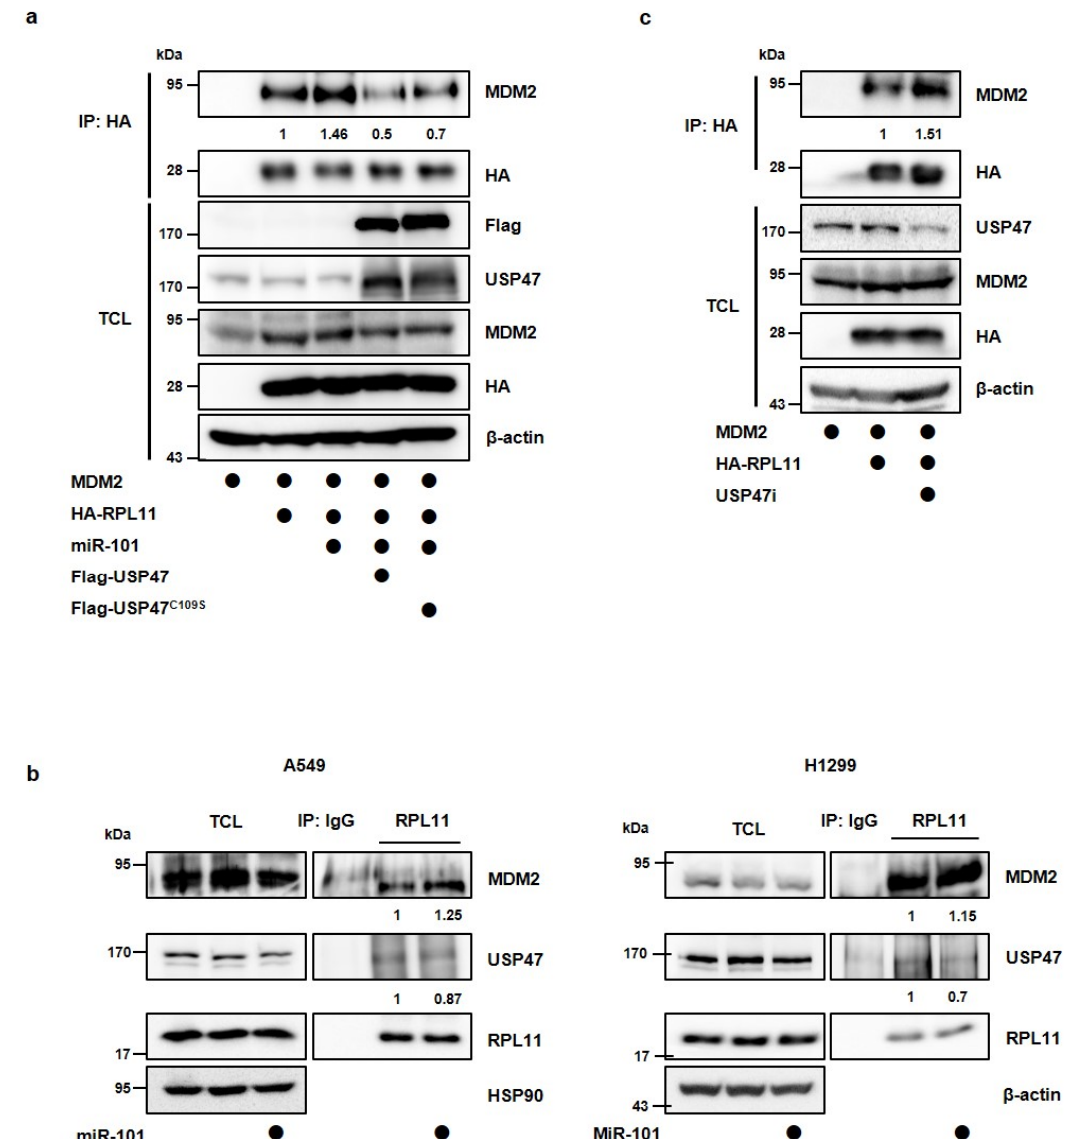
Figure 5. MiR-101-3p increases the interaction between RPL11 and MDM2. ( a ) HEK293T cells were co-transfected with MDM2, HA-RPL11, Flag-USP47, Flag-USP47 C109S , and miR-101-3p mimic. The interaction between MDM2 and HA-RPL11 was detected by immunoblotting after immunoprecipitation with anti-HA agarose beads. The quantification of MDM2 levels in the IP samples was carried out considering the amount of HA in each case of IP samples. ( b ) A549 and H1299 cells were transfected with a miR-101-3p mimic. The interaction between endogenous RPL11 and MDM2, or RPL11 and USP47 was detected by immunoblotting after immunoprecipitation with anti-RPL11 antibody. Quantification of MDM2 or USP47 levels in the IP samples was carried out considering the amount of RPL11 in each case of IP samples. ( c ) HEK293T cells were transfected with siRNA targeting USP47 (USP47i) alone or together with MDM2 and HA-RPL11. The interaction between MDM2 and HA-RPL11 was detected by immunoblotting after immunoprecipitation with anti-HA agarose beads. Quantification of MDM2 levels in the IP samples was conducted considering the amount of HA in each case of IP samples.